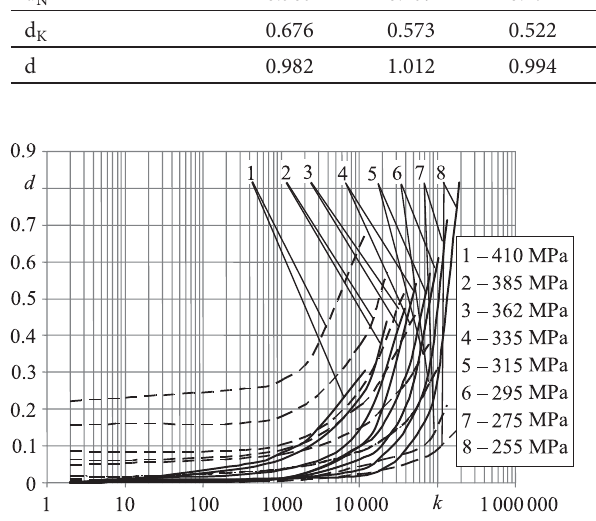
Table 6. Damage accumulation under pulsating stress limited loading σ i , MPa Damage